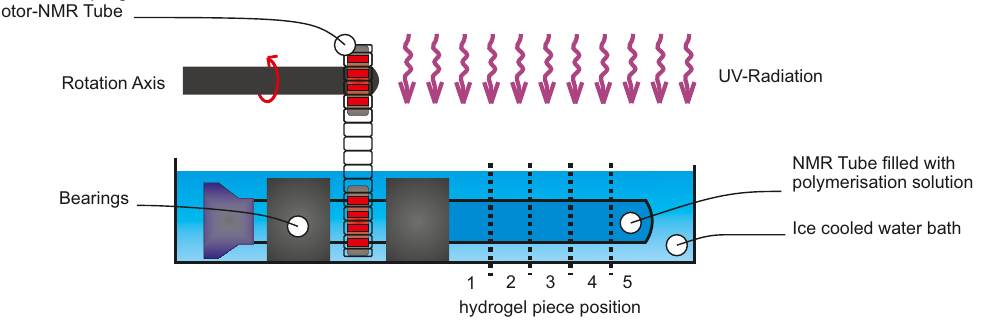
Figure 1. Diagram of the rotation setup for rotating a NMR tube filled with polymerisation solution.